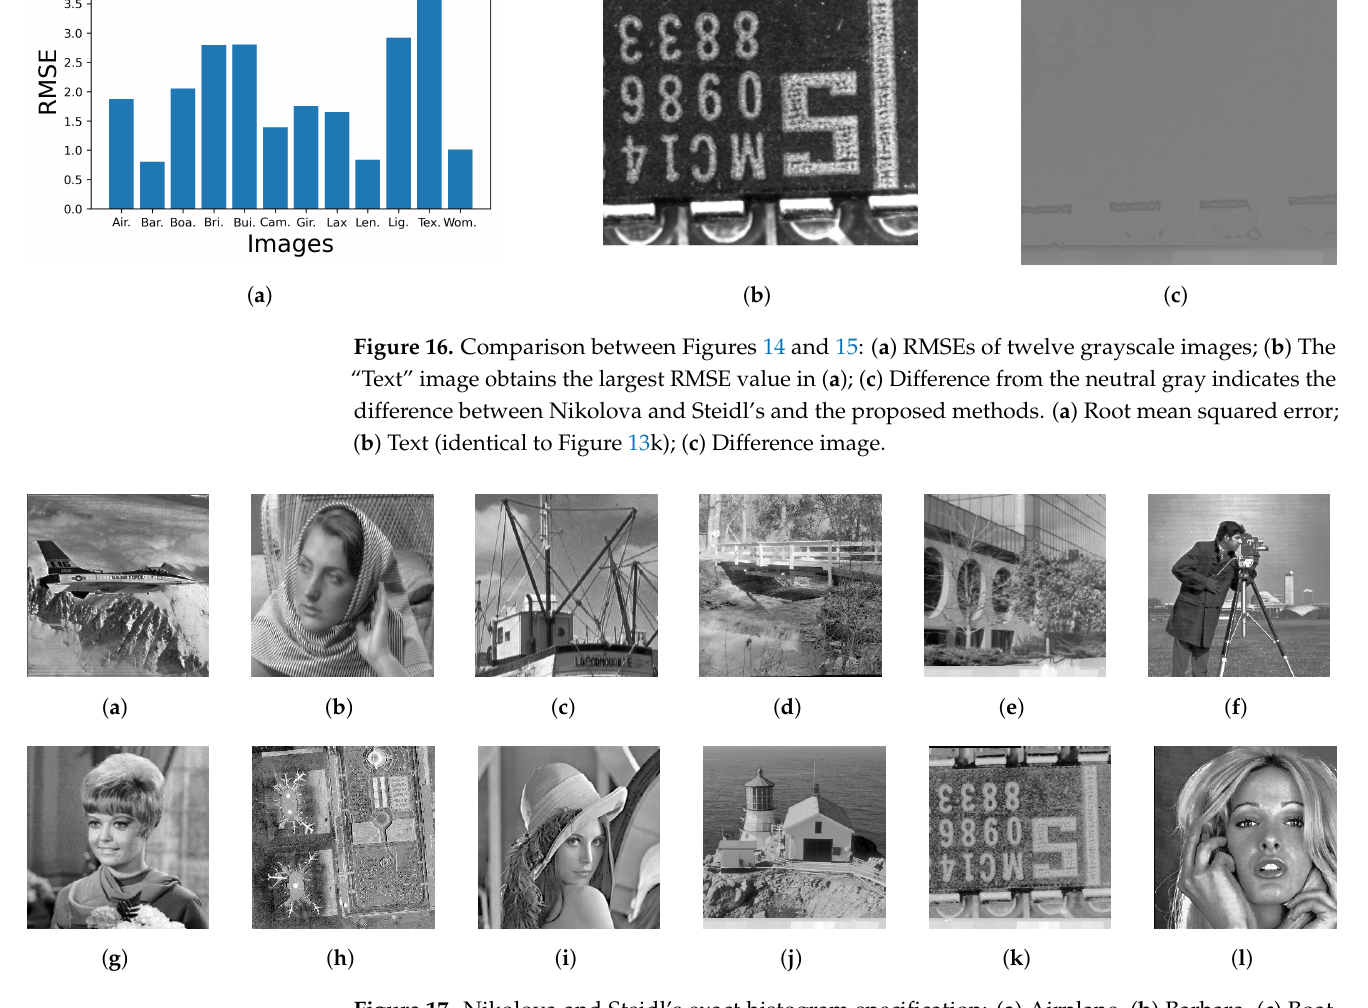
Figure 17. Nikolova and Steidl’s exact histogram specification: ( a ) Airplane, ( b ) Barbara, ( c ) Boat,